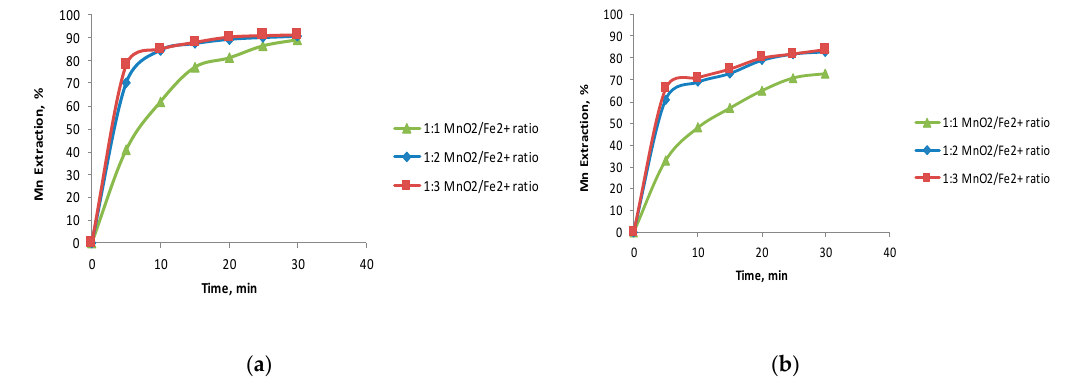
Figure 2. The effect of the Fe 2+ concentration on MnO 2 dissolution ( a ) Black copper sample-1 (BSC-1); Figure 2. The e ff ect of the Fe 2 + concentration on MnO 2 dissolution ( a ) Black copper sample-1 (BSC-1); ( b ) Black copper sample-2 (BCS-2), 25 °C, particle size range of − 75–+53 µm, 1 mol/L H 2 SO 4 . ( b ) Black copper sample-2 (BCS-2), 25 ◦ C, particle size range of − 75– + 53 µ m, 1 mol / L H 2 SO 4